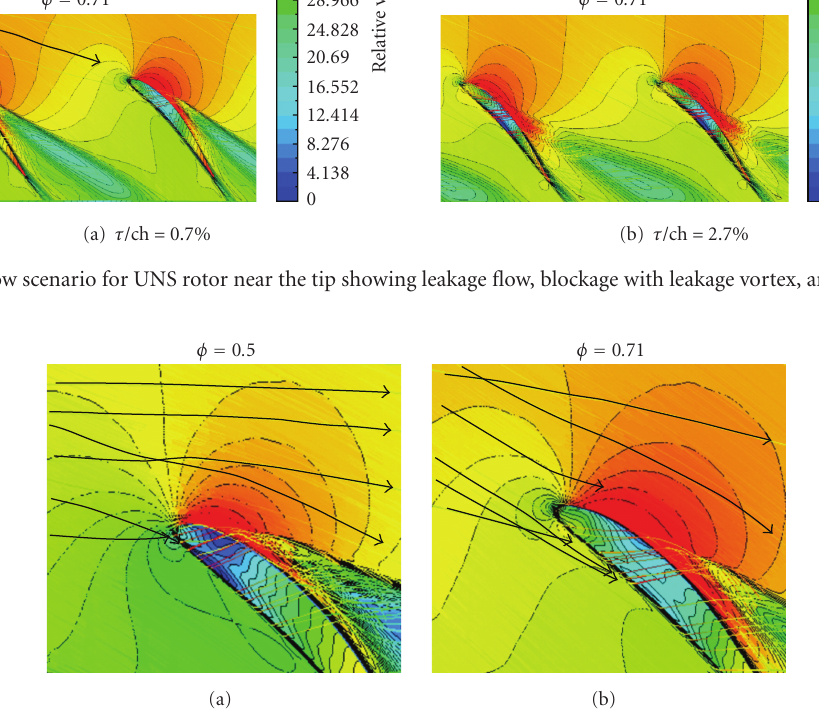
Figure 8: Flow scenario near front portions of the chord, UNS, τ/ ch = 0 . 7%. illustration. Figure 8 is the magnified version of Figure